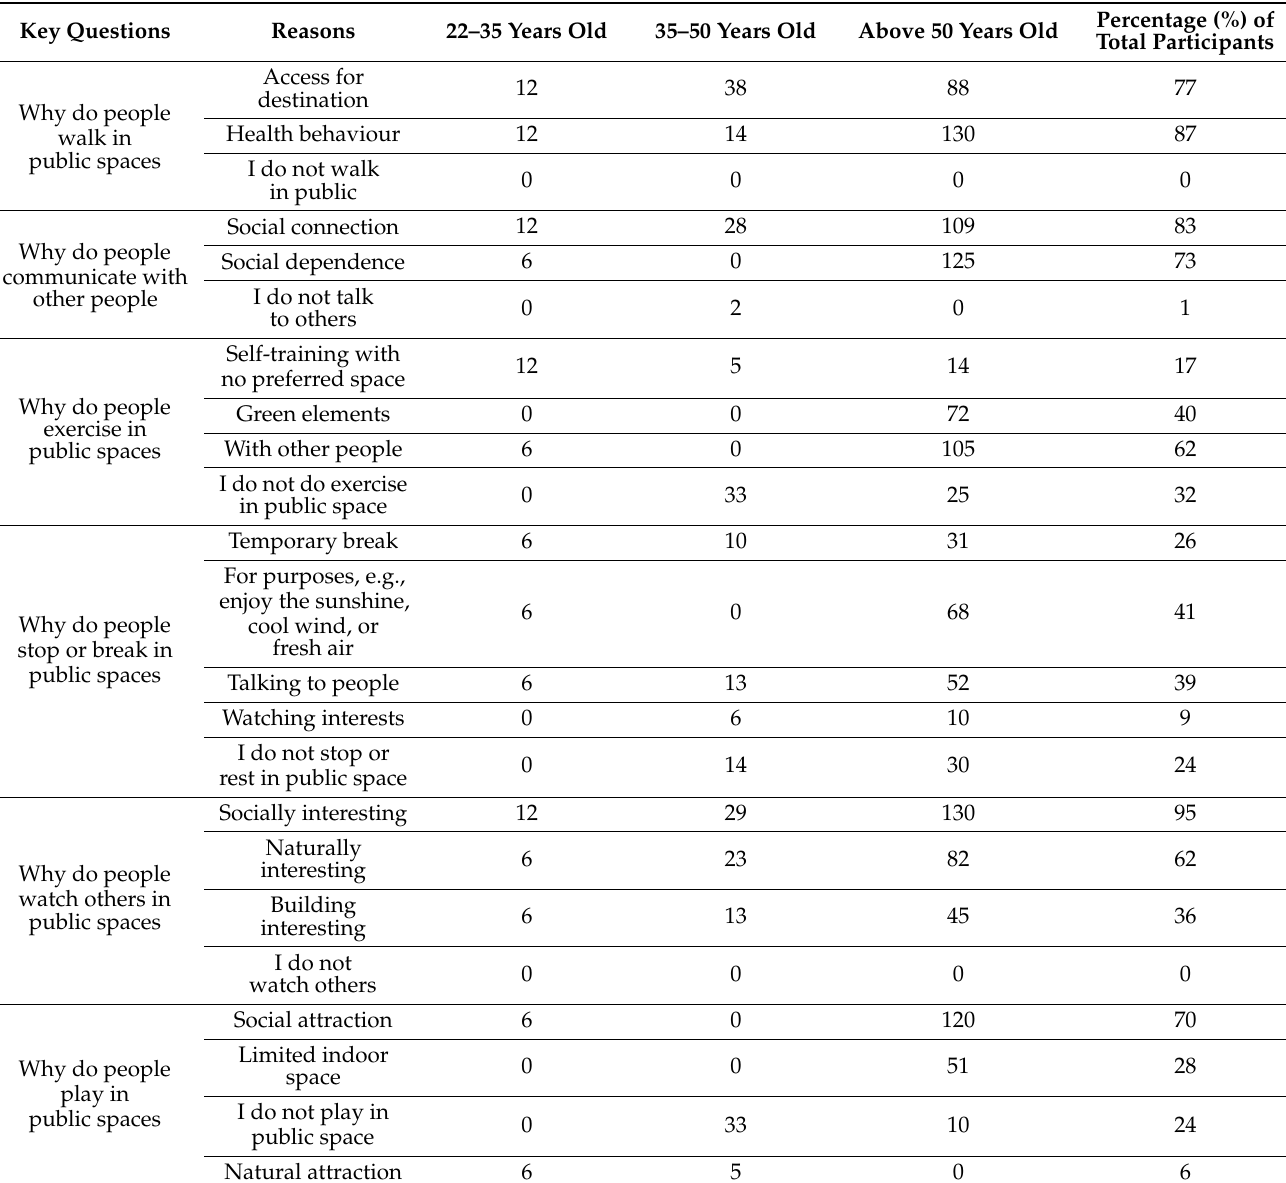
Table 3. Key questions for defining behavioural needs between age